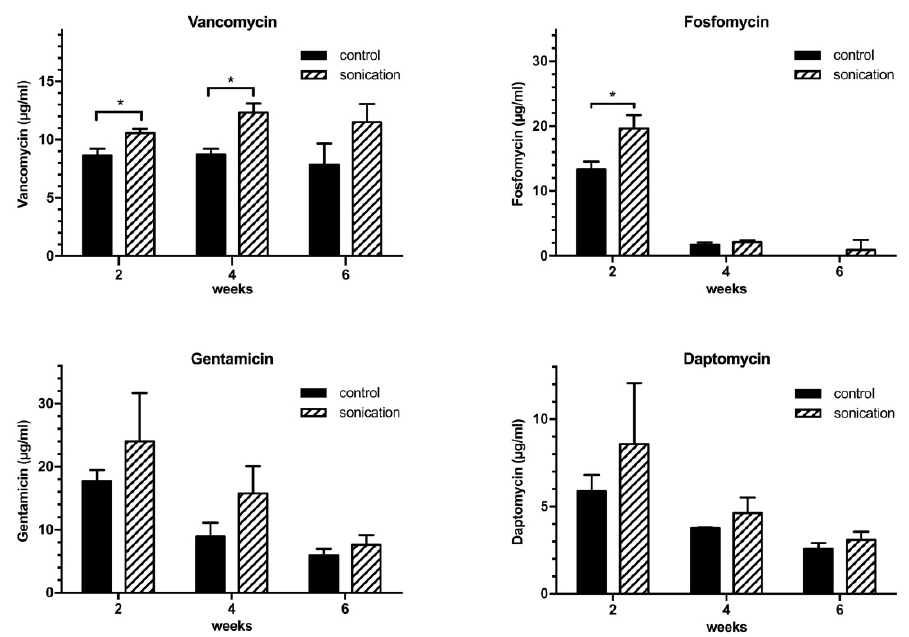
polymerase chain reaction. Figure 2. Effect of sonication on antibiotic release. Mean and standard deviation of triplicate experiments.